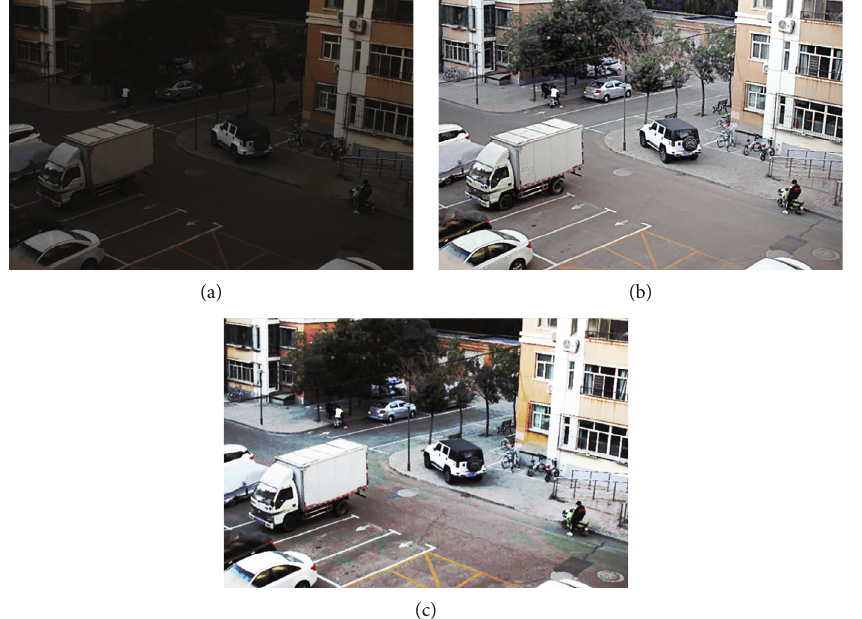
Figure 4: (a) Test chart. (b) MSRCR algorithm. (c) Improved MSR